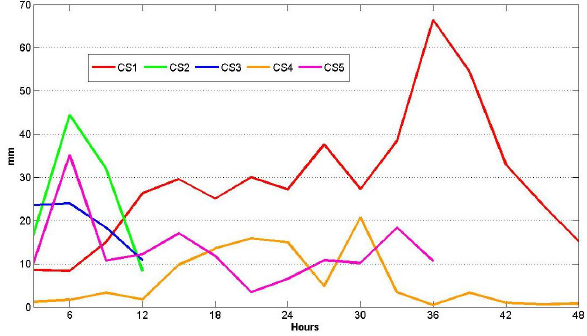
Fig. 3. Evolution of 3-hourly maximum observed precipitation over Figure 3. Evolution of 3-hourly maximum observed precipitation over Catalonia for the 3 Catalonia for the five case five case studies. 4